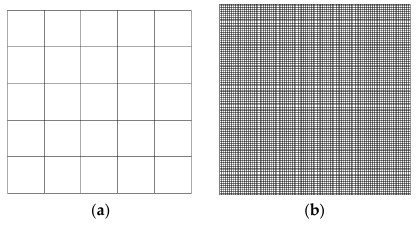
Figure 1. Computational area ( a ) 5 × 5 grids for macrocosmic scale; ( b ) 100 × 100 grids from one macrocosmic grid for microcosmic scale.